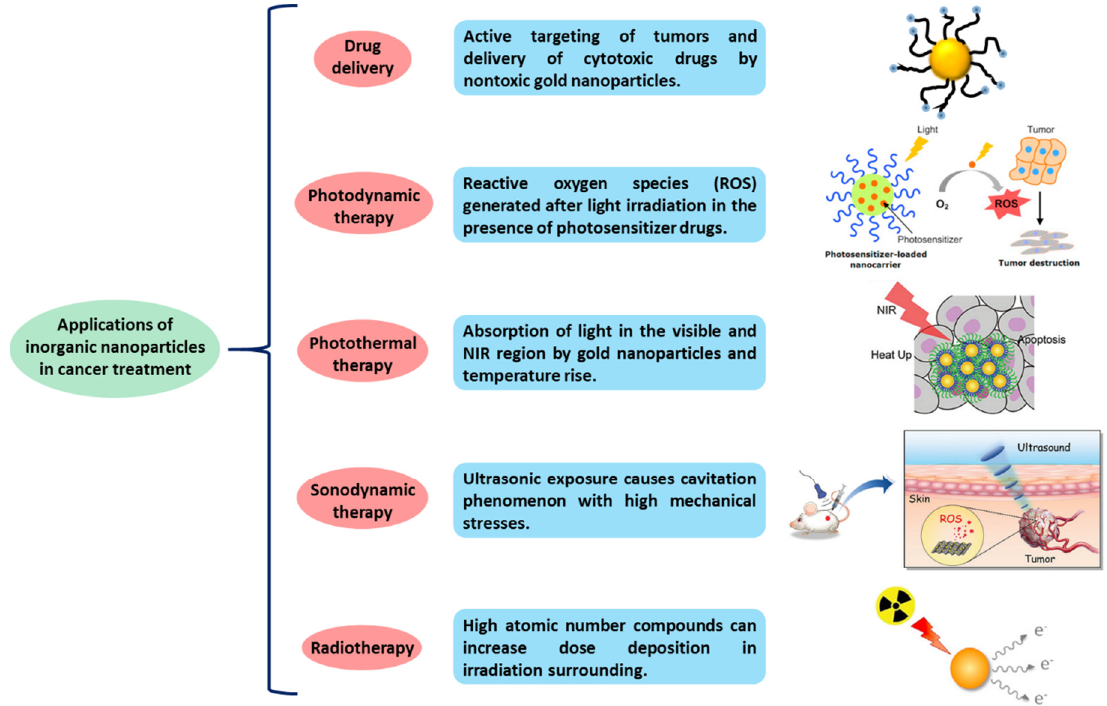
Figure 3. Applications of inorganic nanoparticles in cancer treatment.